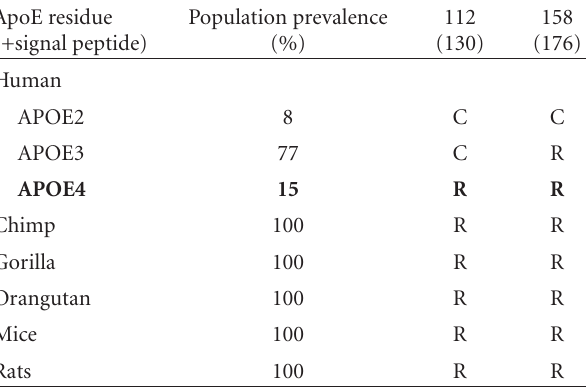
Table 2: APOE polymorphisms in humans and species di ff erences. ApoE